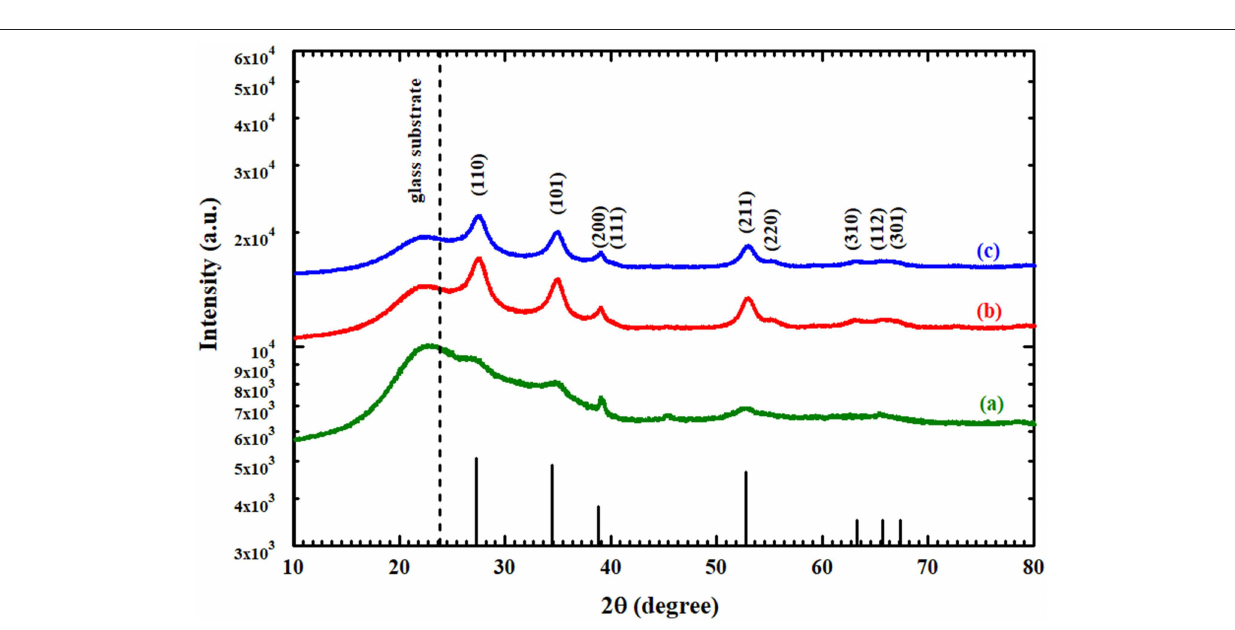
Frontiers in Materials |